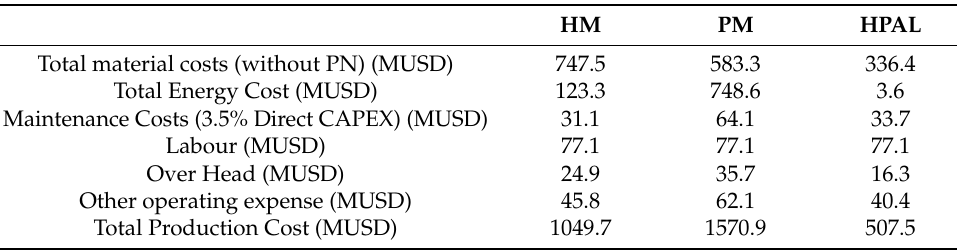
Table 7. Processing variable operating costs estimate for three technologies (HM—hydrometallurgy,